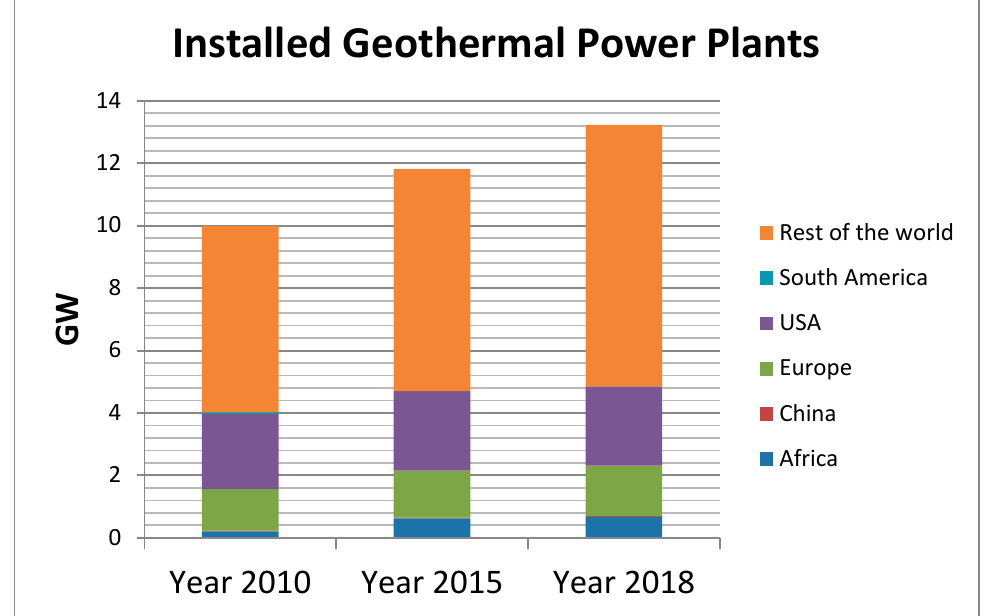
Figure 12. Installed capacities of geothermal power plants for selected world regions [26].